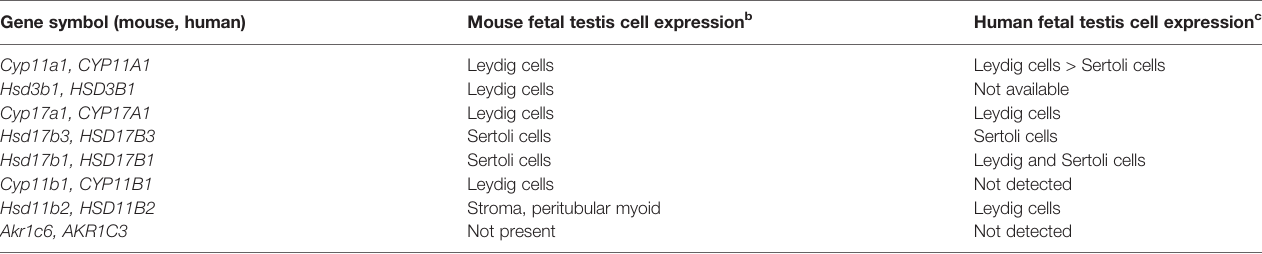
TABLE 1 | mRNA expression patterns of key steroidogenic enzymes in fetal mouse and human testis cells a . Gene symbol (mouse,